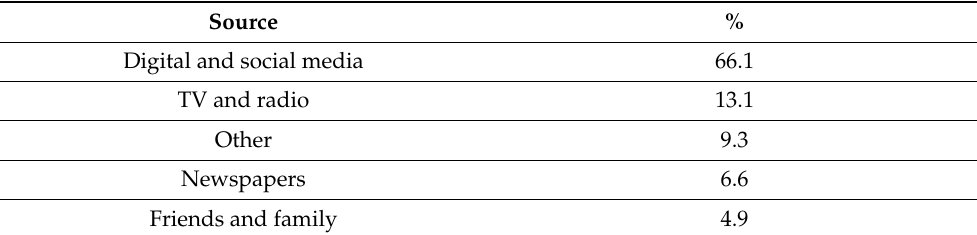
Table 1. The main source of news and information for younger men ( n =